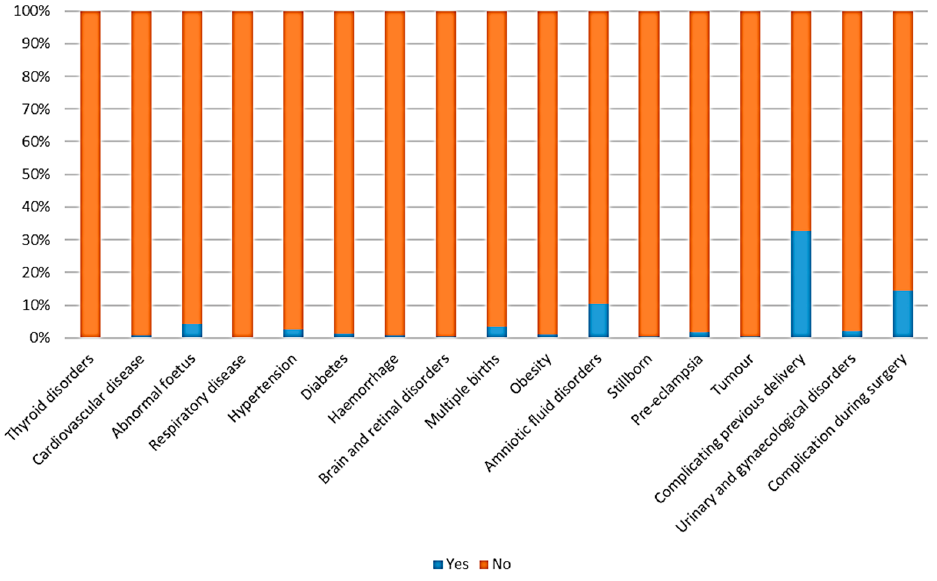
Figure 1. Dichotomous characteristics of the